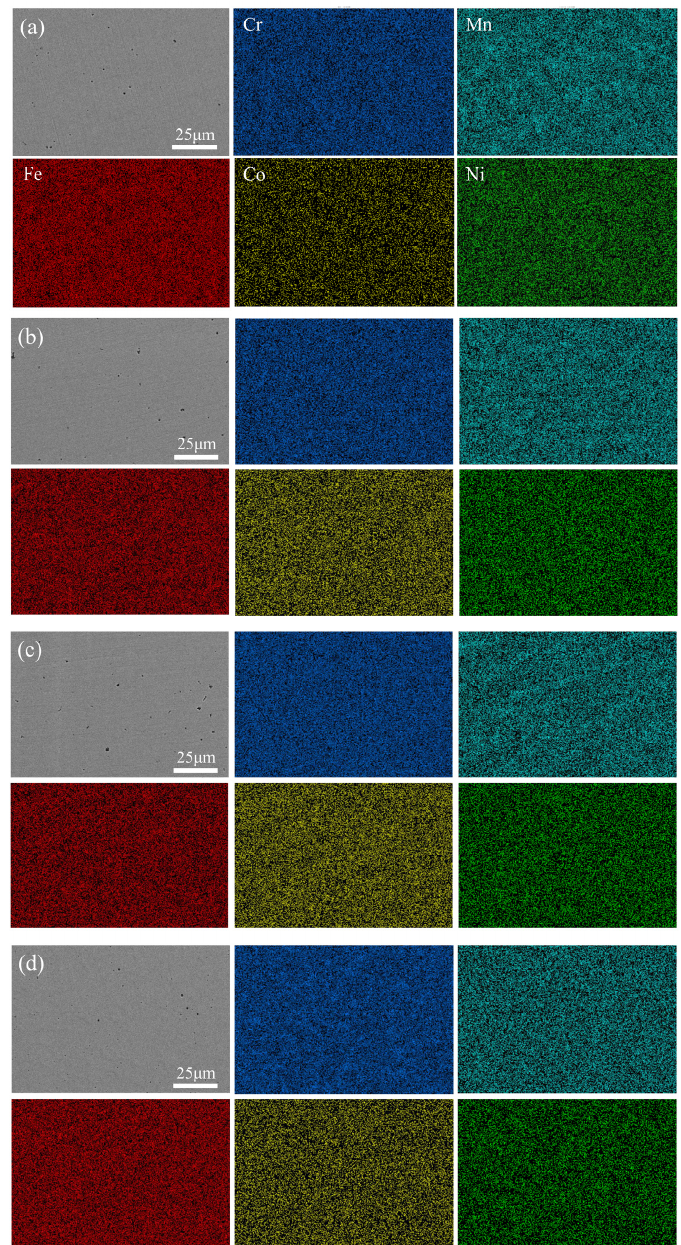
Figure 8. Elemental EDX maps of CoCrxFeMnNi HEA coatings: ( a ) Cr20, ( b ) Cr25, ( c ) Cr30, and ( d ) Cr35.